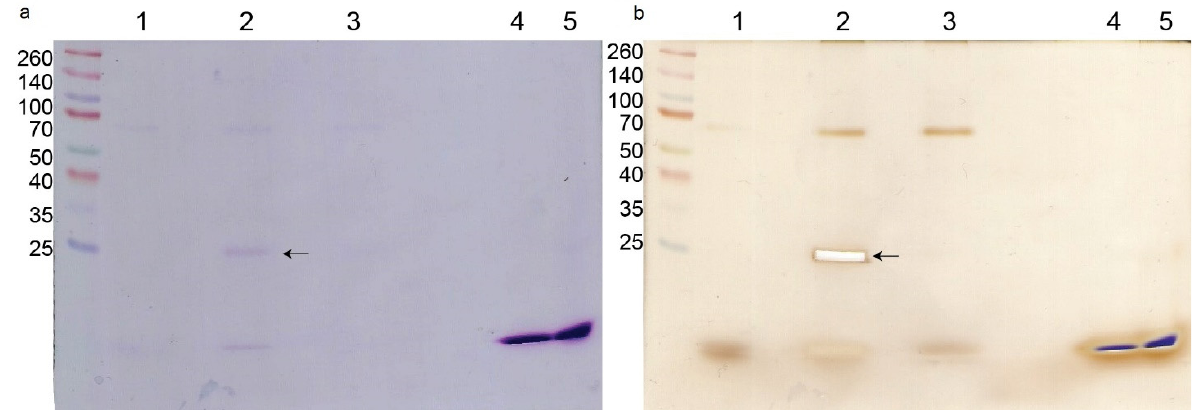
Figure 3. M. luteus protein interactions with crotoxin. SDS-PAGE of proteins separated in the pull-down experiment. ( a ) Coomassie staining, ( b ) silver staining. Lanes are: MW—molecular weight marker; 1—control cells (non-treated); 2—bacterial cells treated with crotoxin; 3—bacterial cells treated with CB subunit; 4—crotoxin alone; 5—CB subunit alone. Arrow indicates the protein interacting with crotoxin that was sent for analysis.